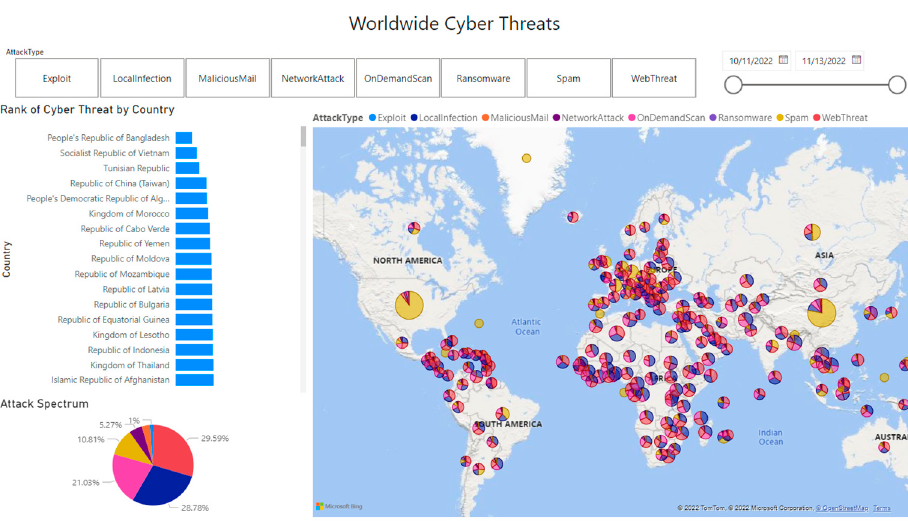
Figure 6. Visualization of cyber ‐ attack data on Microsoft Power BI [49] without writing a single line of code.